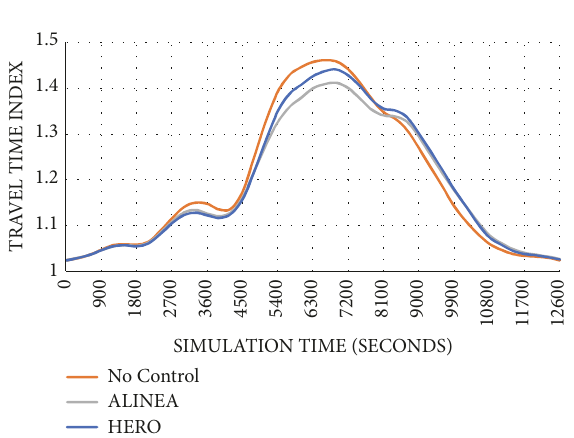
Figure 4: Facility TTI for the three control scenarios or no control, ALINEA, and HERO ramp control. The no control scenario has higher TTI compared to the two ramp control